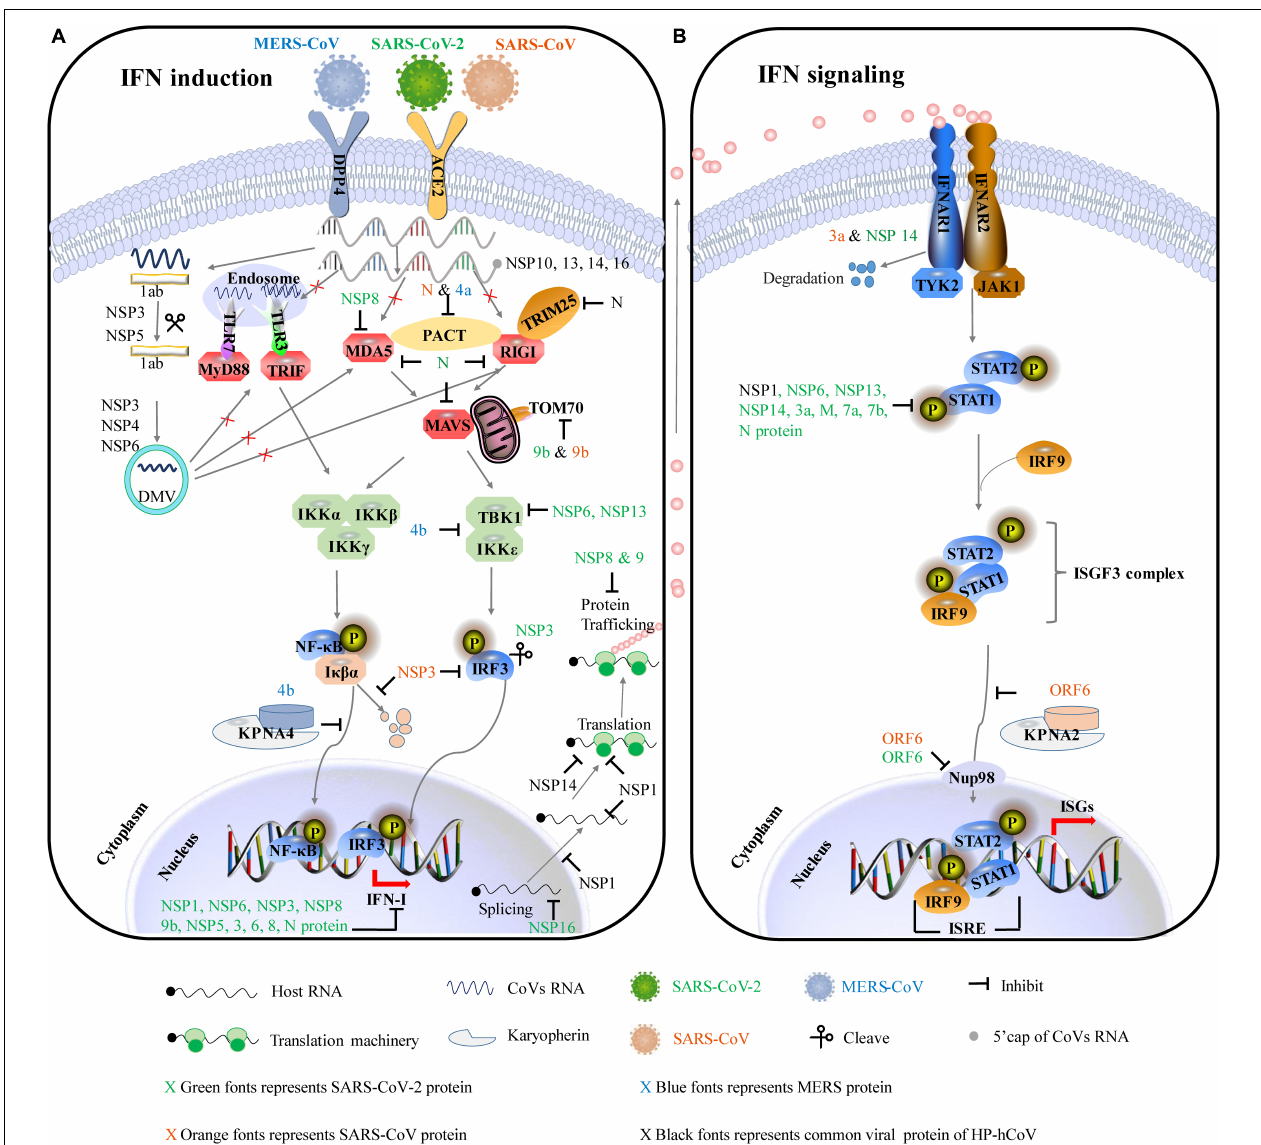
FIGURE 3 | The major immune evasive strategies by HP-hCoVs as discussed in this review. The CoV-encoded proteins inhibit multiple aspects of the host innate immune signaling from sustaining viral replication and propagation. Different colors represent the proteins encoded by different viruses. Green represents SARS-CoV-2 encoded proteins, orange represents SARS-CoV encoded proteins, blue represents MERS-CoV encoded proteins, and black represents their common proteins. Virus antagonistic tactics are shown with black lines and arrows. (A) HP-hCoVs uses multiple gene products to impair IFN induction. To shield viral RNA (ssRNA and dsRNA) from recognition by PRRs, CoV replication takes place and DMVs are formed by NSP3, NSP4, and NSP6. In addition, NSP10, NSP13, NSP14, and NSP16 can modify the 5 (cid:48) -cap structure of viral RNA to mask viral PAMPs. HP-hCoVs interfere with the transmission of signals at almost every step. HP-hCoV N proteins interact with TRIM25, interfering with RIG-I signaling. MERS-CoV 4a and SARS-CoV N associate with PACT, sequestering the association of PACT and RIG-I/MDA5. SARS-CoV-2 NSP8 interacts with MDA5 to interfere with IFN induction. SARS-CoV-2 N is reported to associate with RIG-I, MDA5, and MAVS. SARS-CoV-2 and SARS-CoV M proteins are reported to associate with multiple adapters (not shown). SARS-CoV-2 and SARS-CoV 9b proteins interact with human TOM70 to block signaling downstream of MAVS. MERS-CoV ORF4b could specifically interact with TBK1 and IKK ε , thereby blocking IRF3 phosphorylation. In addition, MERS-CoV ORF4b can associate karyopherin- α 4 (KPNA4), out-competing NF- κ B for KPNA4 binding and suppressing NF- κ B nuclear transport. SARS-CoV NSP3 binds to IRF3 and inhibits the degradation of I κ B α . SARS-CoV-2 NSP3 can cleave IRF3 directly. HP-hCoV NSP1 efficiently interferes with the cellular translation machinery. SARS-CoV-2 NSP16 disrupts mRNA splicing. SARS-CoV-2 NSP8 and NSP9 interfere with host protein trafficking. (B) HP-hCoVs use multiple gene products to impair IFN signaling. SARS-CoV 3a and SARS-CoV-2 NSP14 can degrade IFNAR1. SARS-CoV and SARS-CoV-2 ORF6 bind directly to Nup98 and Rae1 to prevent bidirectional nucleocytoplasmic transport. SARS-CoV ORF6 associates karyopherin- α 2 (KPNA2), retaining KPNA2 in the cytoplasm and suppressing STAT1 nuclear import. SARS-CoV-2 NSP6, NSP13, NSP14, 3a, M, 7a, 7b, and N protein inhibit the phosphorylation of STAT1. HP-hCoV NSP1 inhibits the phosphorylation of